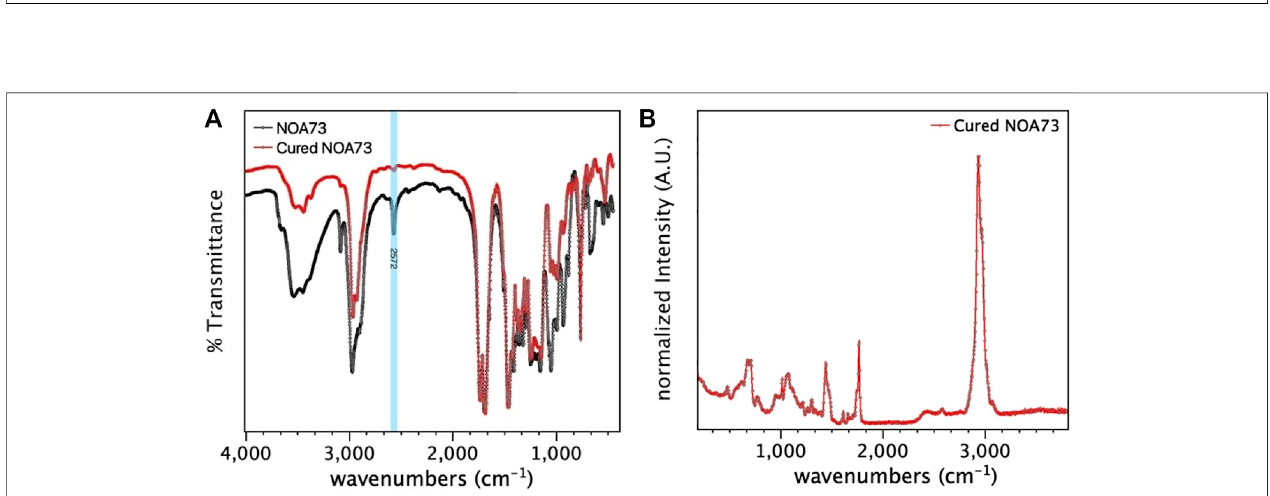
FIGURE 2 | Aluminum substrate after surface treatment. (A) Confocal Laser microscope image. Top view of the aluminum surface after the mechanical abrasion process. (B) 3Dreconstructedimageandtopographicpro fi leofaluminumsurfaceaftermechanicalabrasion. (C) PictureofthesurfaceoftheAA2024T351afterabrasion process.